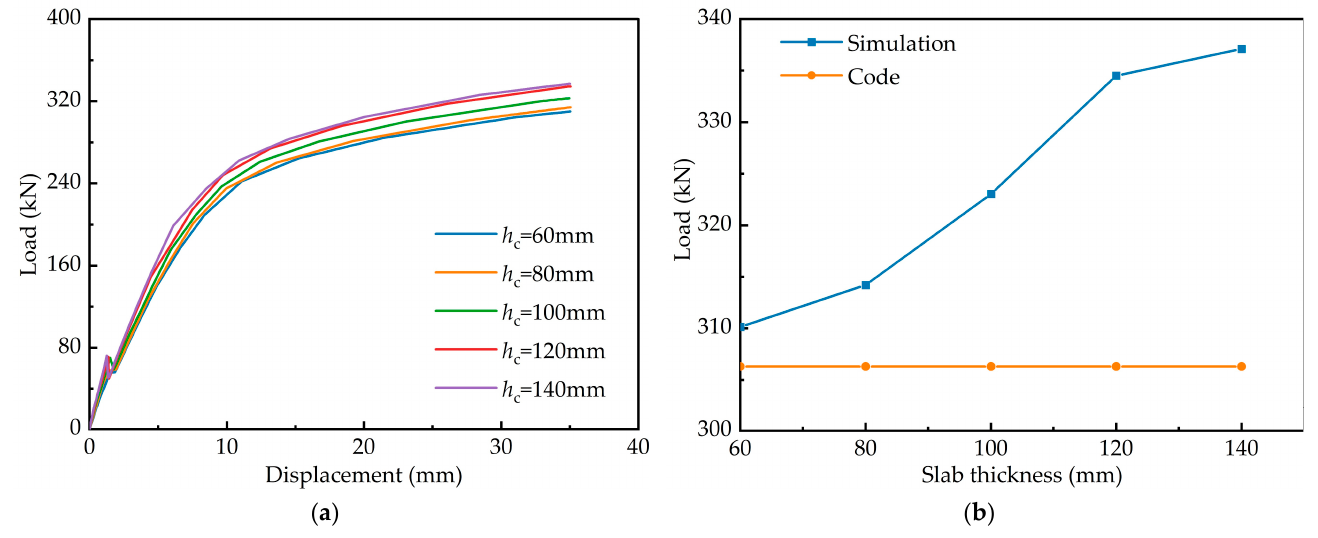
Figure 15. Effects of slab thickness: ( a ) load–deflection curves; ( b ) comparison of flexural bearing capacity.